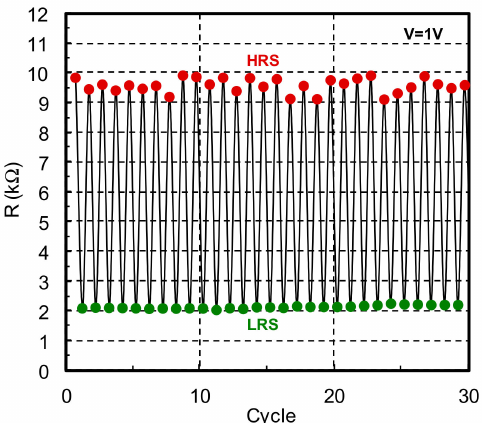
Figure 4. Repetition characteristic of the α -GTO thin-film device with double layers of di ff erent oxygen density.